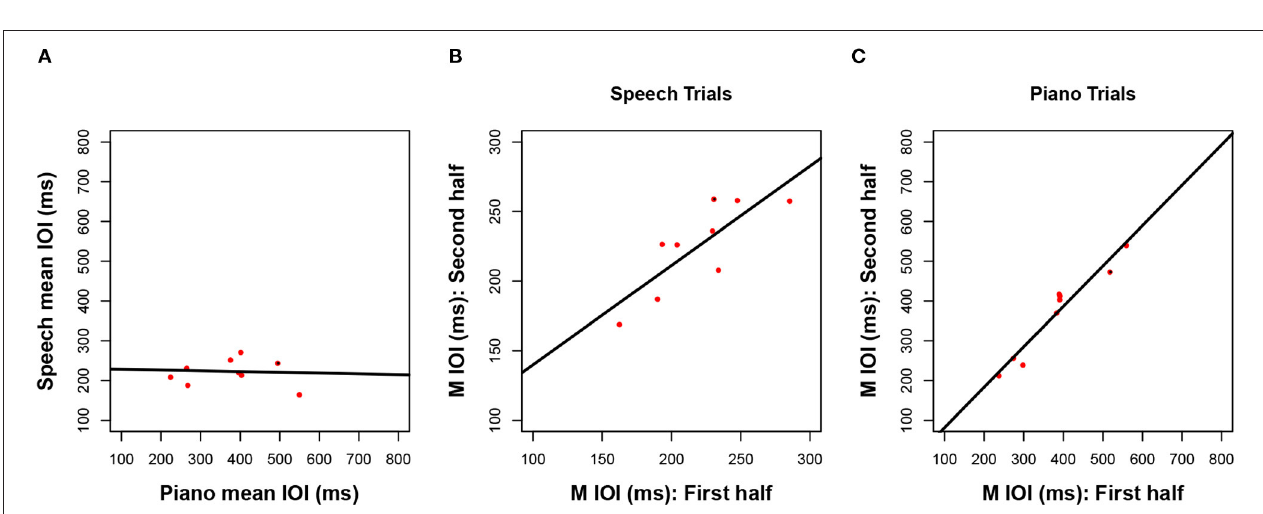
FIGURE 6 | Scatterplots of mean IOI across speech and piano tasks (A) , within speech (B) and within piano (C) for bilingual speakers ( N = 9 each panel). The darkened data point highlights the French L1 participant.